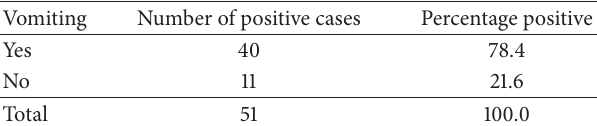
Table 2: Frequency of vomiting in rotavirus diarrhoea in children in Sokoto.